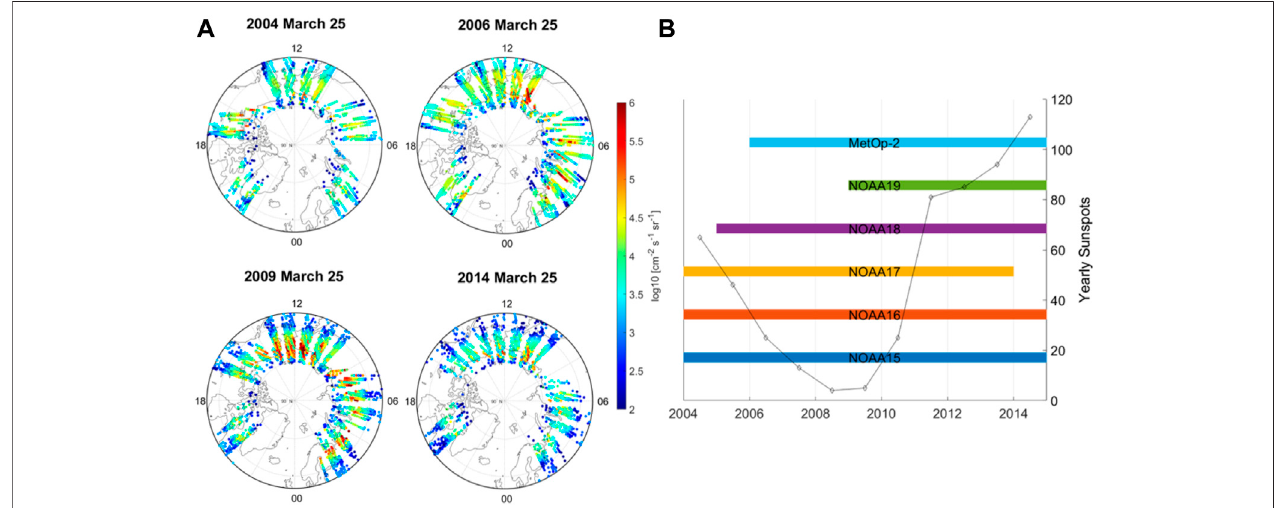
FIGURE1|(A) :ThePOESand MetOpsatellite MLTcoverage over afulldayduringMarch 25thin2004,2006,2009and 2014. (B) :ThePOESand MetOpsatellite coverage over a full solar cycle from 2004 to 2014.